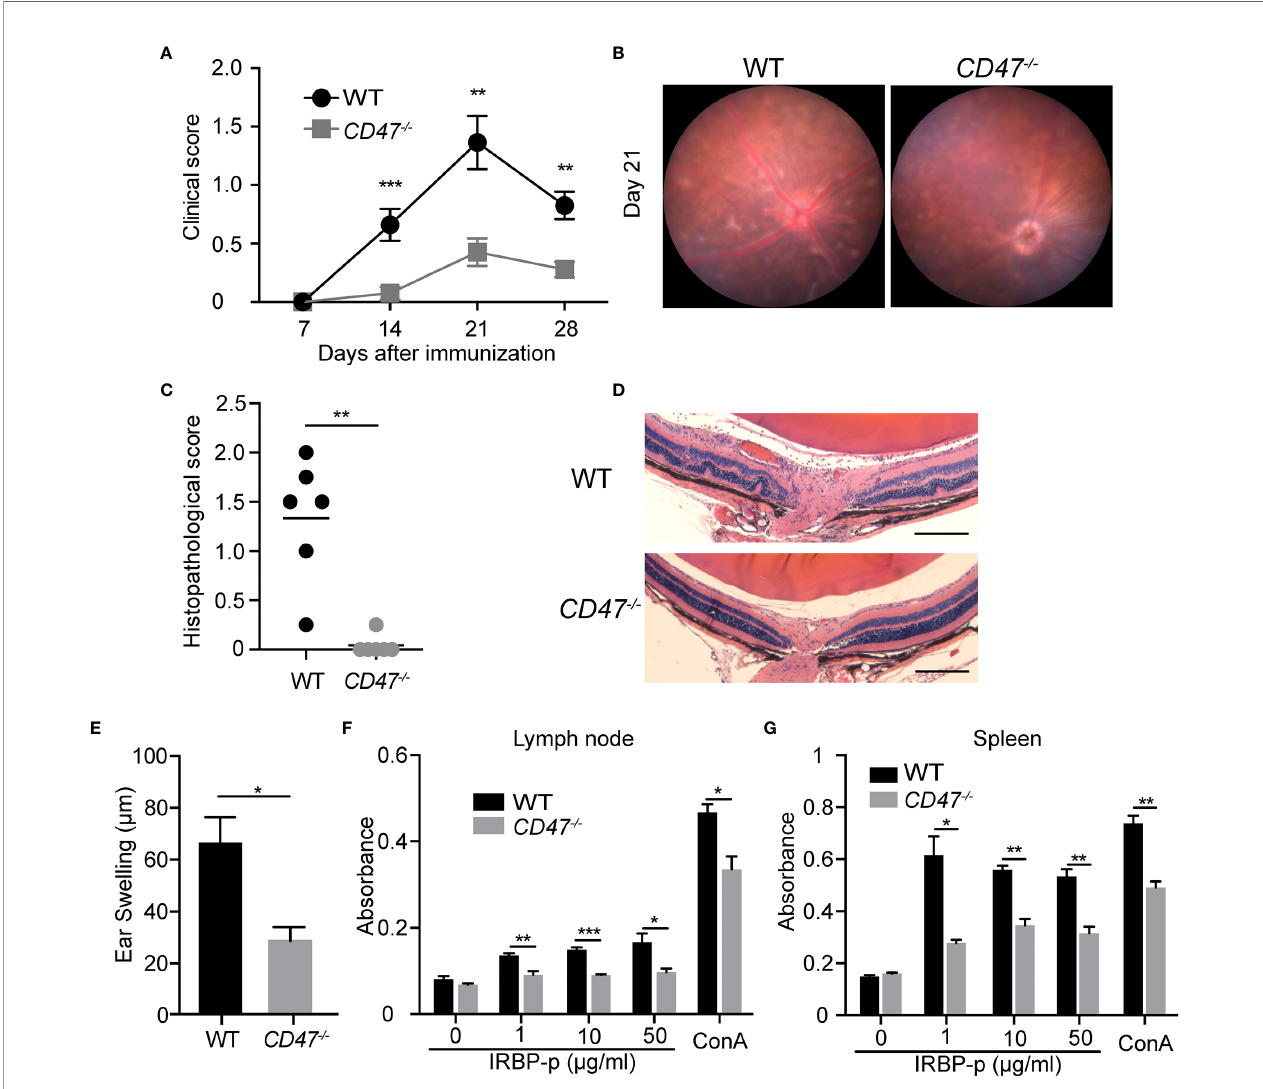
FIGURE 1 | CD47 de fi cient mice are protected from autoimmune uveitis. Female WT and CD47 -/- mice were immunized with IRBP-p and the animals were evaluated for (A – D) severity of retinal in fl ammation and (E – G) systemic immune responses against the IRBP-p. (A) Time course of EAU clinical scores were evaluated by fundus observation (n =10-11 mice per group). (B) Representative retinal fundus images on day 21. (C) Histopathological EAU score was evaluated on day 21 (n = 6 mice per group). (D) Representative histopathological (H&E staining) images (Scale bars: 200 m m). (A, C) Data were analyzed by Mann – Whitney U